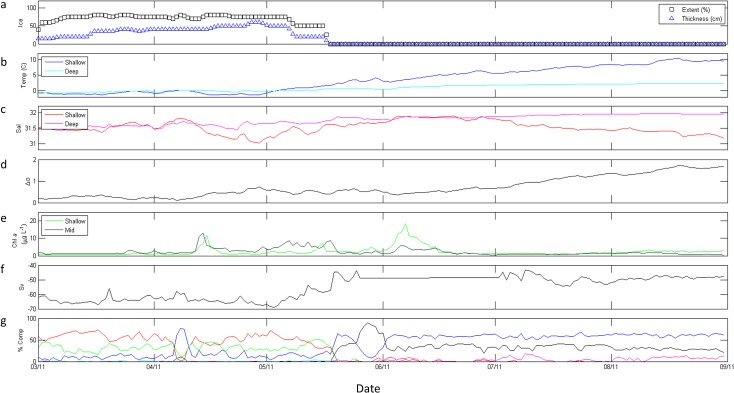
M2 data from March through August 2011.(a) ice extent (%, black boxes) and thickness (blue triangles); (b) shallow (dark blue) and deep (cyan) temperature (° C); (c) shallow (red) and deep (magenta) salinity; (d) stratification (Δσ); (e) shallow (light green) and mid-column (dark green) Chl a fluorescence (μg L-1); (f) total scattering volume (Sv); (g) percent composition of classes of scatterers, including SmCrust (black), MdCrust (blue), LgCrust (red), WkReson (green), StReson (cyan), and Unclass (magenta).